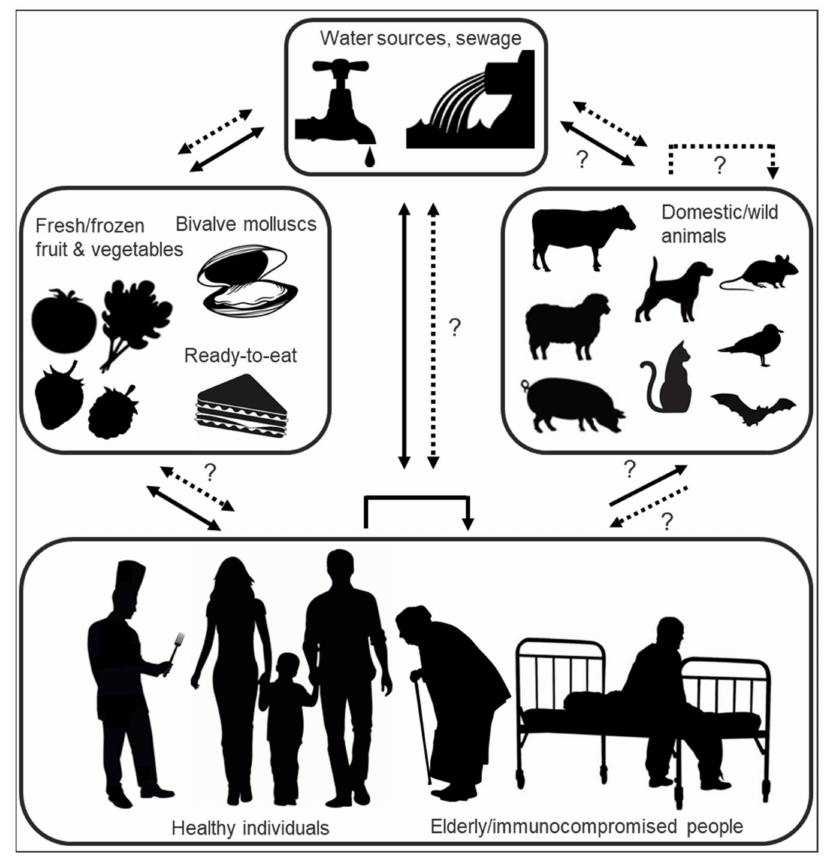
Figure 4. Norovirus transmission. Transmission routes of human noroviruses (solid arrows) and animal noroviruses (dashed arrows) are shown. Unconfirmed transmission is indicated by a question mark. The dashed arrow indicating transmission between domestic/wild animals denotes species- specific transmission; the question mark accompanying it indicates putative interspecies